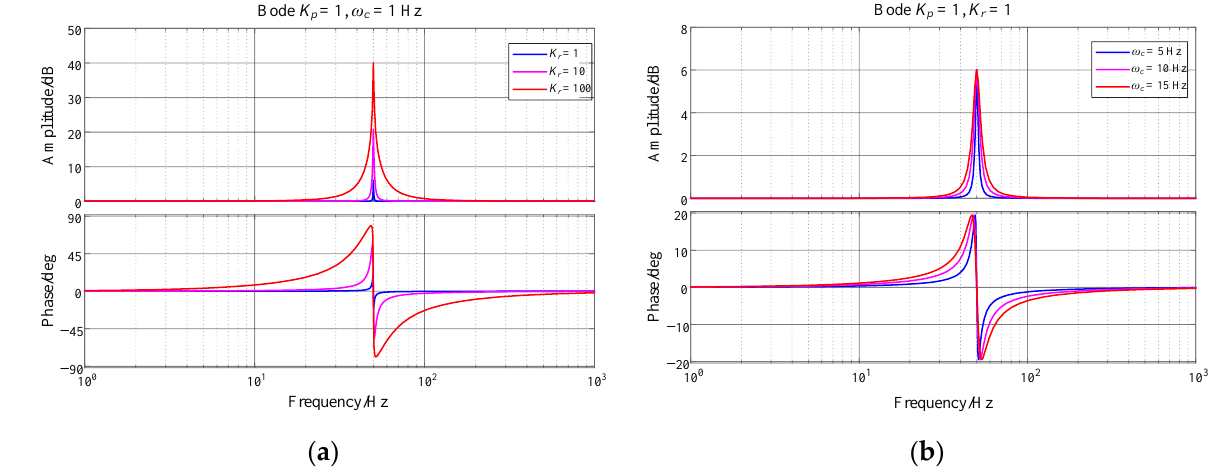
Figure 8. ( a ) Bode diagram of PR controller when parameter K r changes. ( b ) Bode diagram of PR controller when parameter ω c changes.